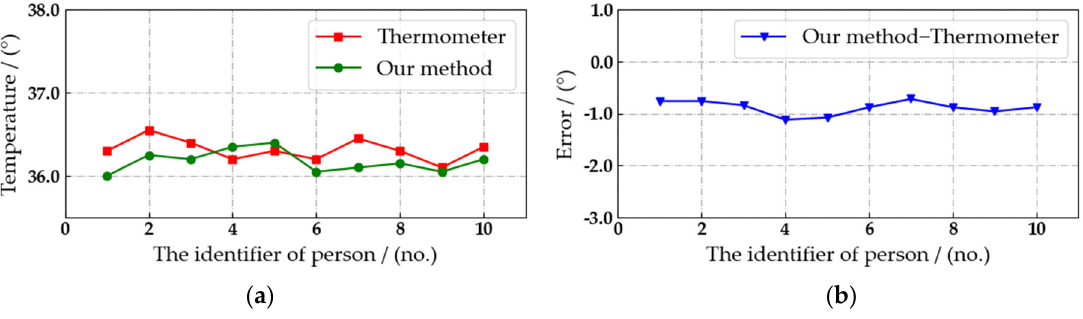
Figure 18. Comparison of pedestrian body temperature detection results at a distance of 4 m. ( a ) Temperature detection results. ( b ) Detection error.